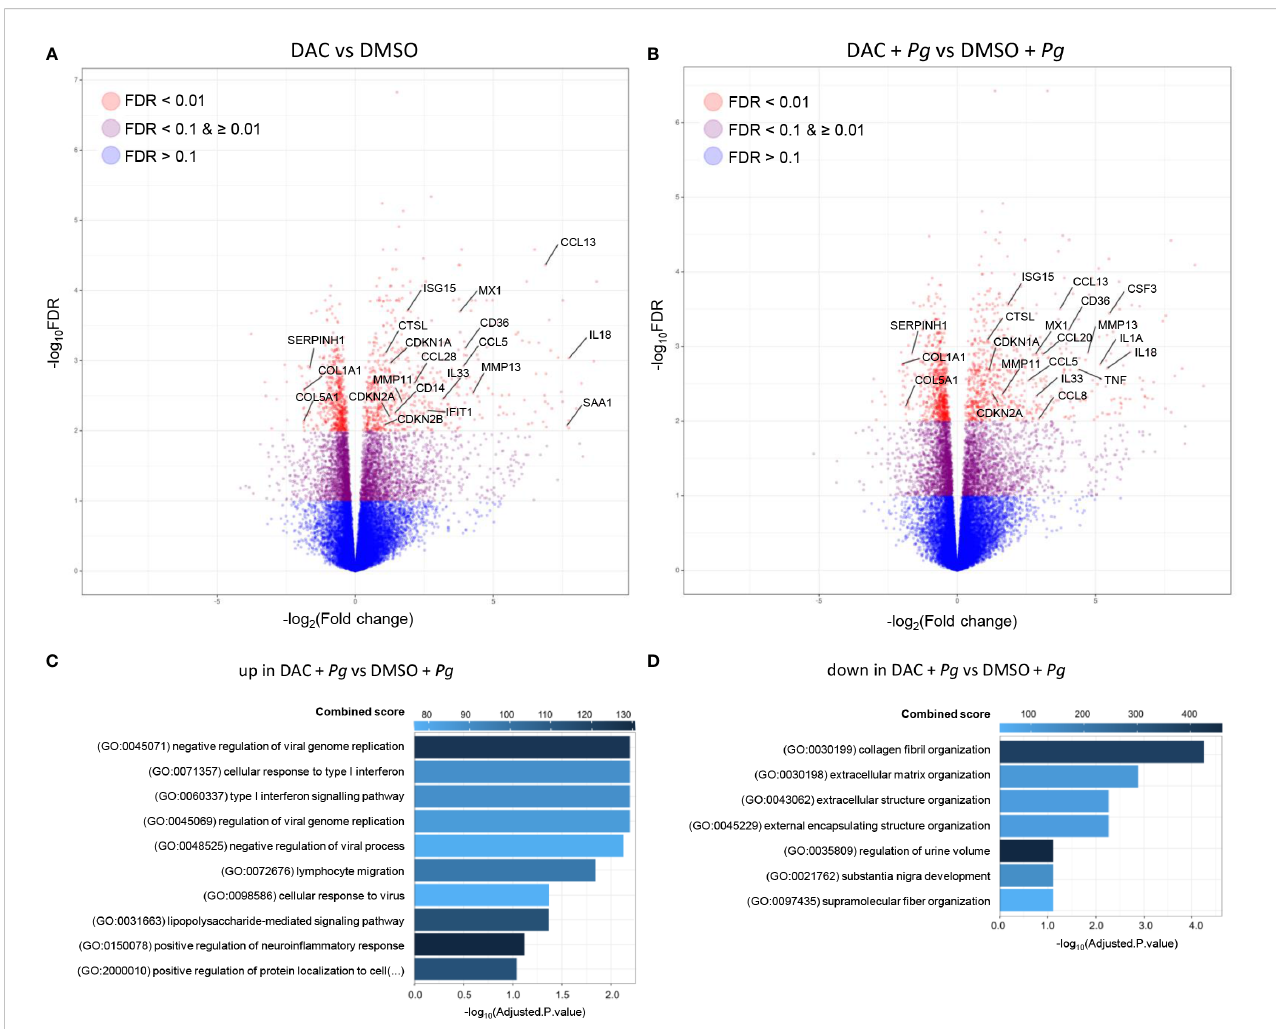
FIGURE 5 DAC induces global transcriptional changes in GFs. GFs (n=5) treated with DMSO or DAC for 12 days were left unstimulated in medium or were infected with P. gingivalis ( Pg , MOI 20) for 4 h and mRNA expression was pro fi led by next generation sequencing. (A, B) Volcano plots of RNA-seq data showing the log 2 FC and -log 10 (FDR) of DMSO- and DAC-treated GFs in the absence (A) and presence (B) of P. gingivalis infection. (C, D) Pathway enrichment analysis of signi fi cantly upregulated (C) and downregulated (D) genes in DAC-treated GFs infected with P. gingivalis . Top hits based on Combined Score and adjusted P -value < 0.1 are